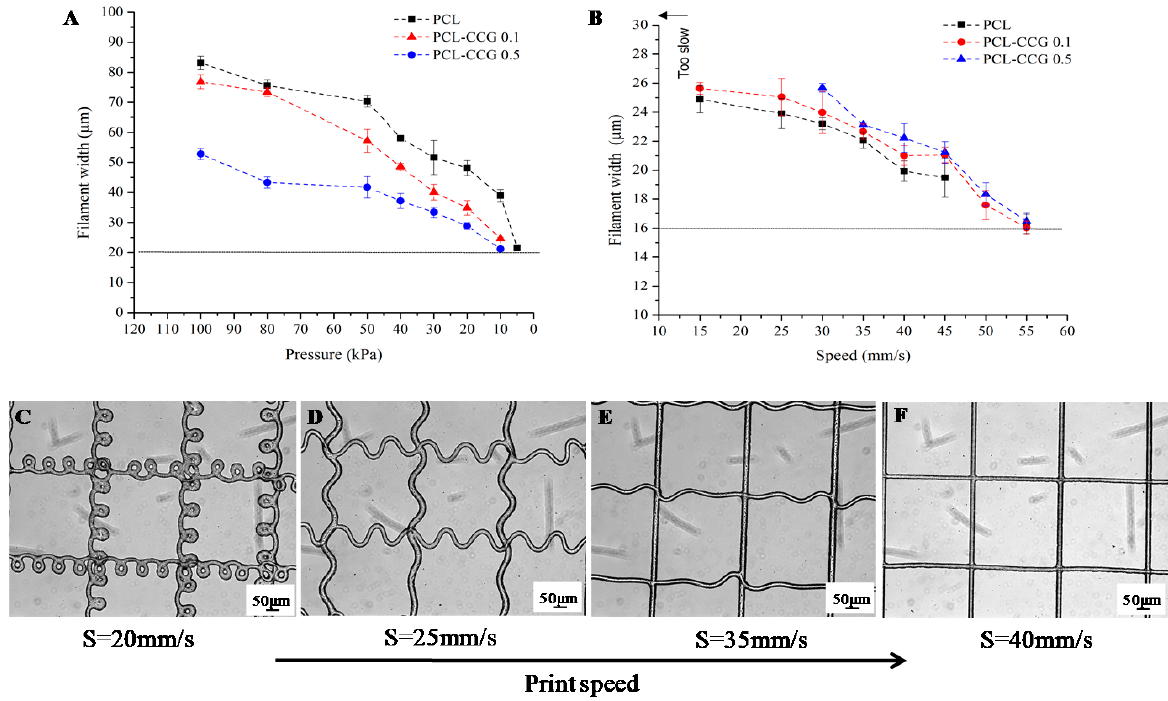
Figure 5. Filament width of MEW PCL against ( A ) pressure and ( B ) speed. As printing speed in- creases ( C – F ), the coiling of fibres reduced until a critical speed of 40 mm/s is reached.